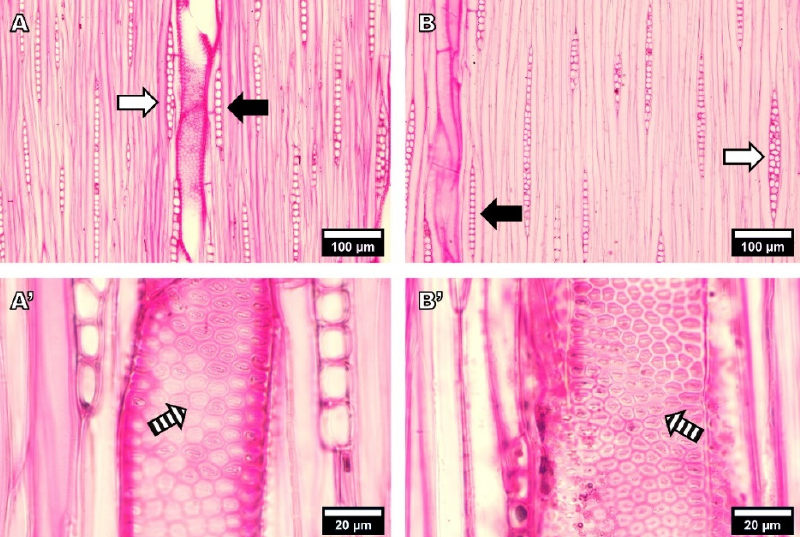
Figure 5. Optical micrographs of the tangential sections of Acacia mangium ( A , A’ ) and A. hybrid ( B , B’ ). Uniseriate ray (black arrow), biseriate ray (white arrow), and vestured intervessel pit (striped arrow).